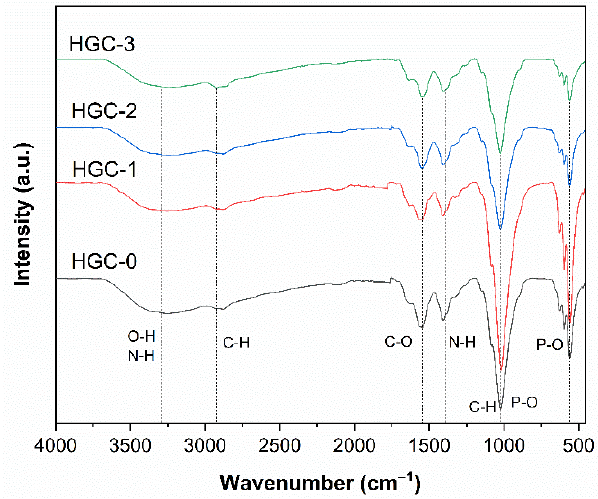
Figure 3 . FTIR spectra of various HGC beads. Figure 3. FTIR spectra of various HGC